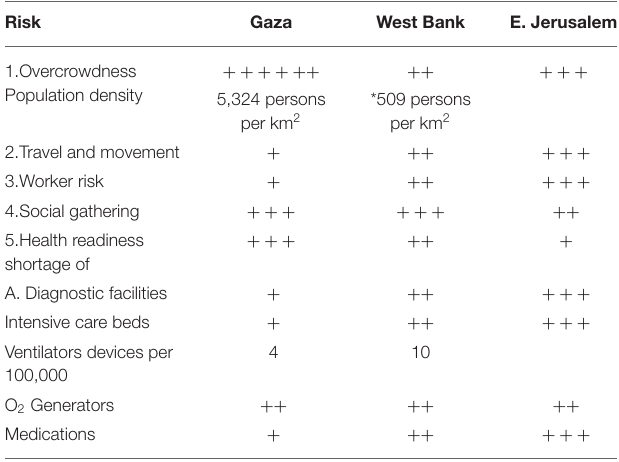
TABLE 1 | COVID-19 in selected countries, mid-March 2021. Country